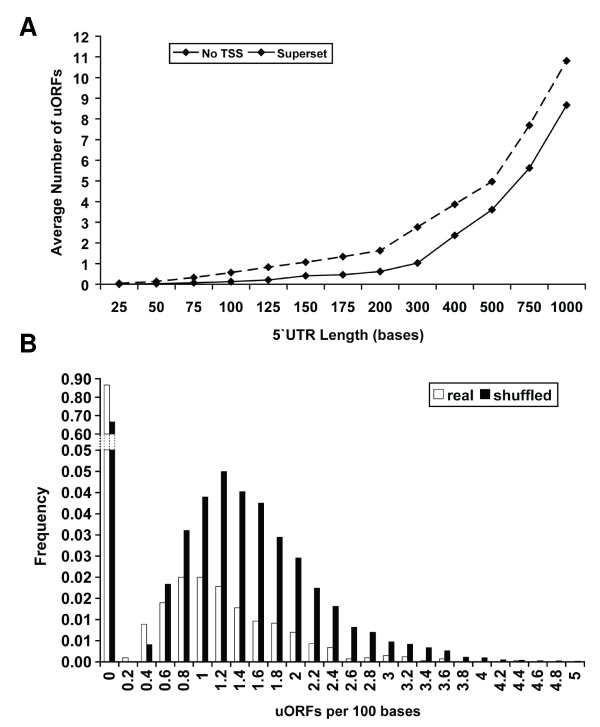
Statistical significance in yeast upstream sequences and 5' UTRs. In A), the average number of uORFs is shown for both upstream regions in general (No TSS) and TSS mapped 5' UTRs (Superset). The same number of sequences (4149) is used in all cases for the "No TSS" line. At all points, there are fewer uORFs in the real 5' UTR sequences, In B), a normalised frequency histogram of uORF numbers in real and shuffled 5' UTRs highlights the reduced chance of observing a uORF in real UTR sequence compared to random. Over 85% have none compared to 68% by chance.